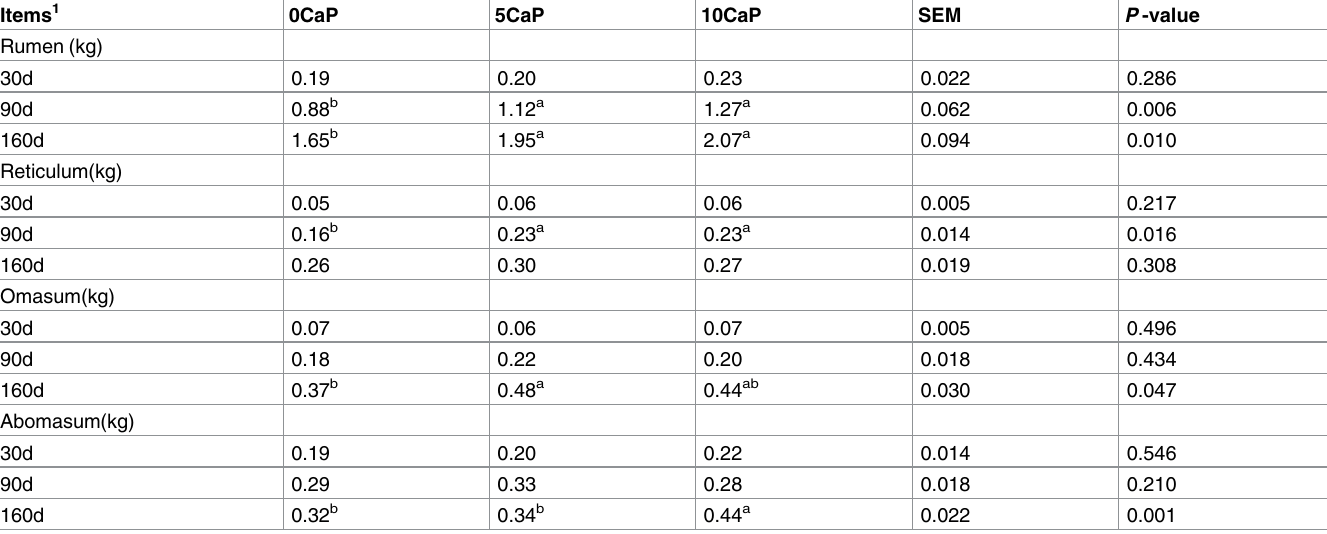
Table 4. The stomach development of calvessupplemented with calcium propionate at various stages of growth